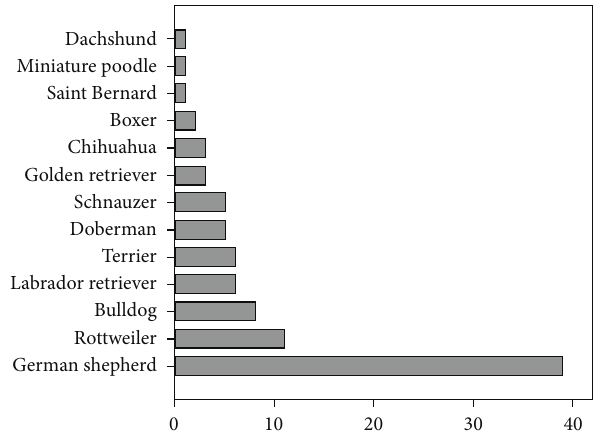
Figure 1: Dog types (21.1% known, 78.9%